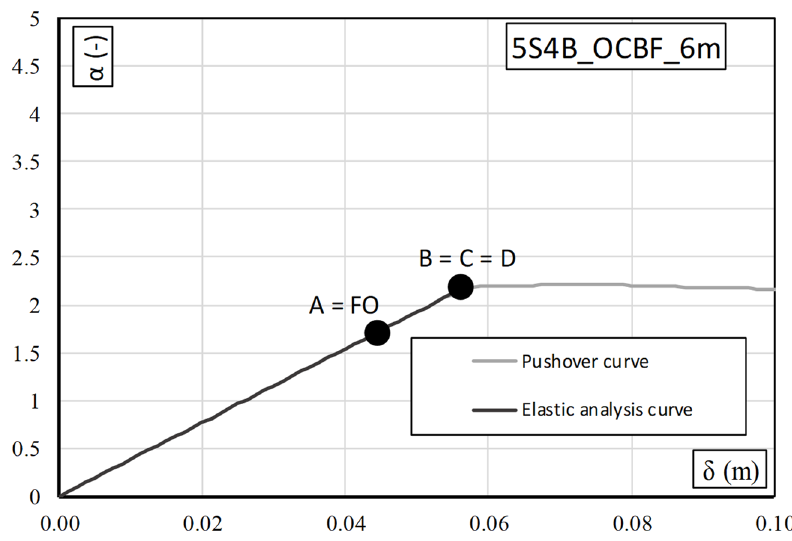
Figure 10. Trilinear model and characteristic points for the structure 5S4B_OCBF_6 m.